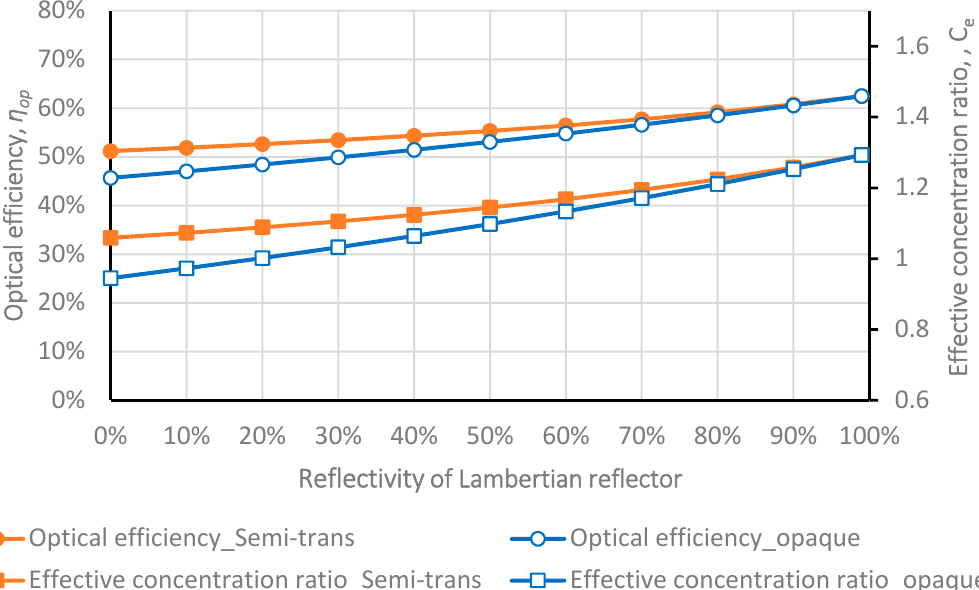
Figure 7. The optical efficiency and effective concentration ratio as a function of the diffuse reflectivity of the opaque and semi-transparent reflectors.